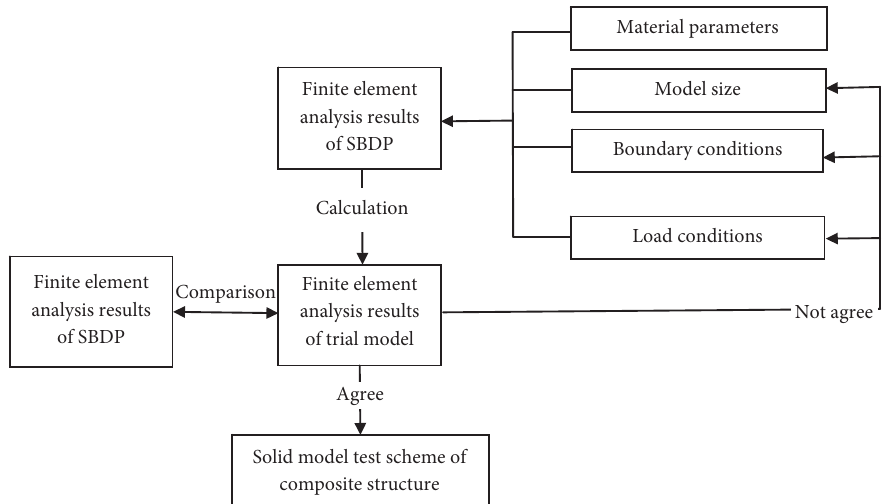
Figure 3: Design flow chart of the cooperative entity unit model for SBDP.